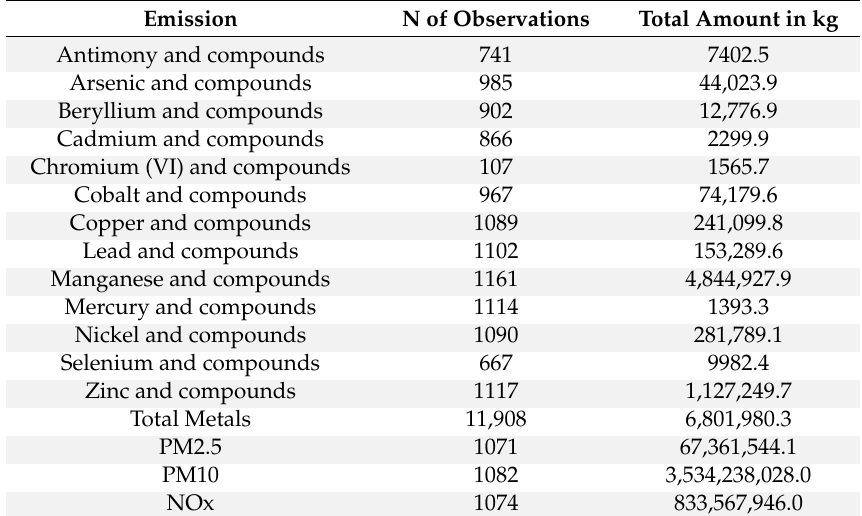
Table 1. Air emissions from coal mines in kilograms,